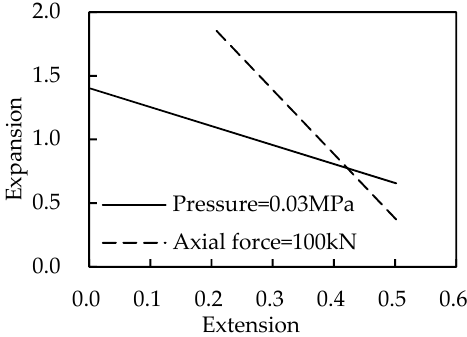
Figure 8. Deformation under specific loads.